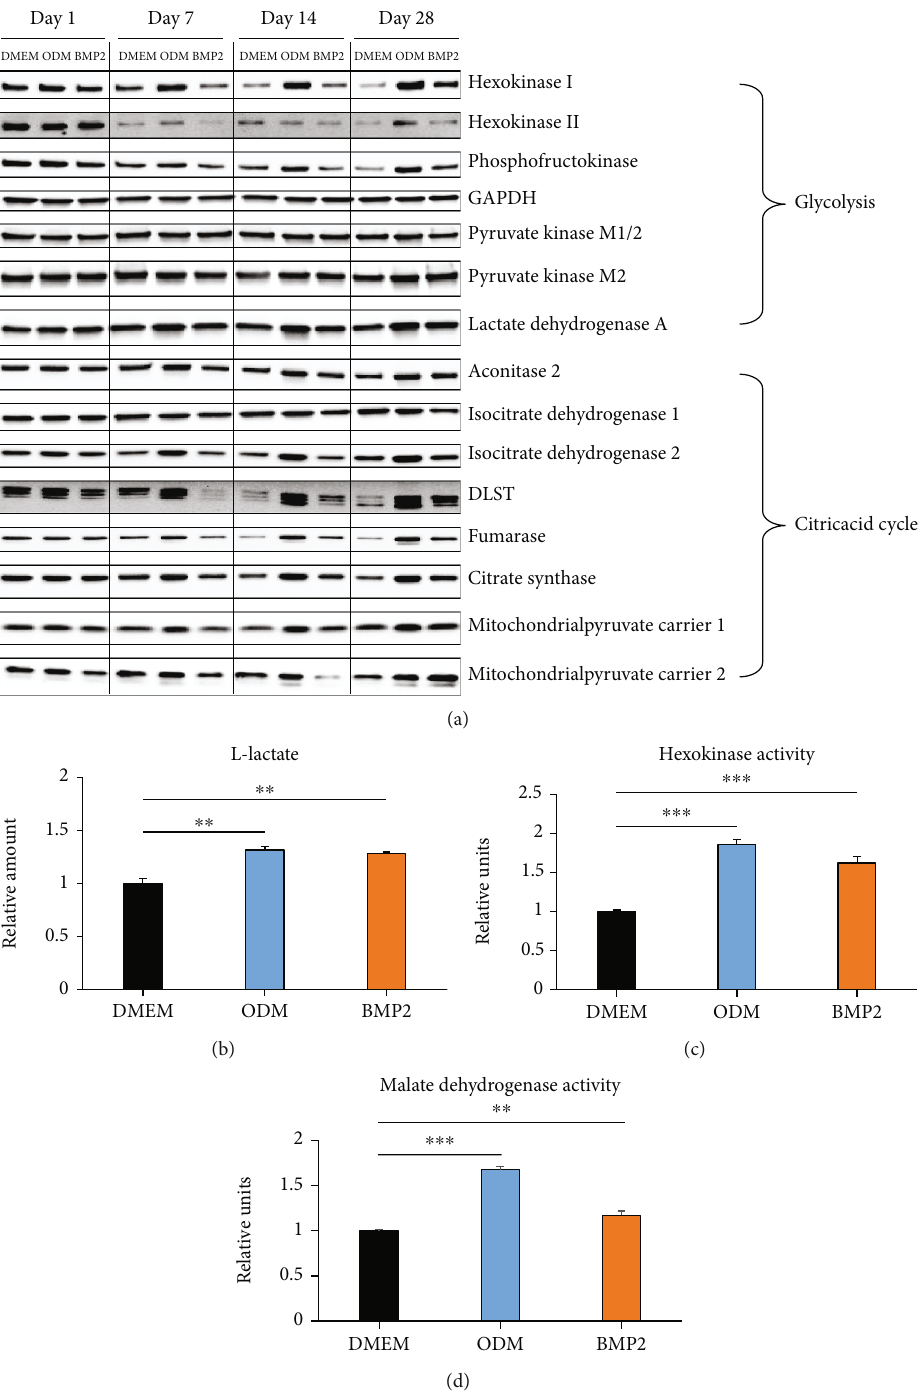
Figure 1: Expression of glycolysis and citric acid cycle markers during osteogenic di ff erentiation of DFCs. (a) DFCs were cultured in osteogenic di ff erentiation medium (ODM), BMP2 di ff erentiation medium, or control medium (DMEM) for one, seven, 14, and 28 days before protein expression of the glycolysis markers hexokinase I, hexokinase II, phosphofructokinase, glycerinaldehyd-3-phosphat-dehydrogenase (GAPDH), pyruvate kinase M1/2, pyruvate kinase M2, and lactate dehydrogenase A, and protein expression of the citric acid cycle markers aconitase 2, isocitrate dehydrogenase 1, isocitrate dehydrogenase 2, dihydrolipoamide succinyltransferase (DLST), fumarase, citrase synthase, mitochondrial pyruvate carrier 1, and mitochondrial pyruvate carrier 2 were determined by western blot analysis. Quanti fi cation results and statistical